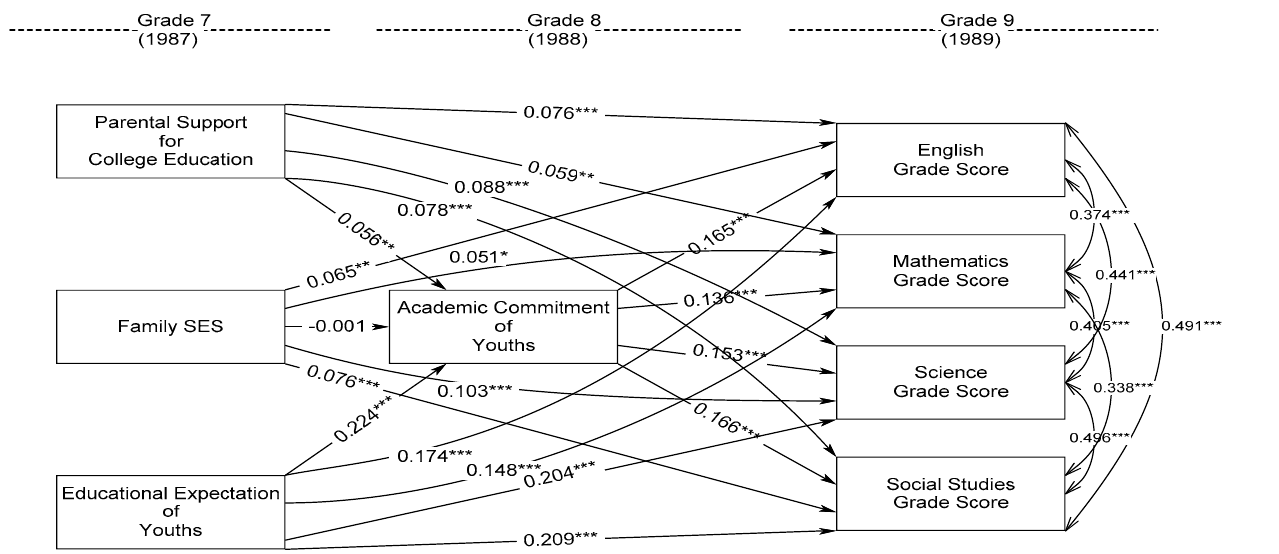
Figure 1. Standardized Effects of Parental Support for College Education, Family SES, and Educa- tional Expectation of Youths in Grade 7 on Youths’ Grade-9 Educational Performance through Youths’ Grade-8 Academic Commitment (Model 1). Note. The gender, family structure, and ethnic origins of youths were adjusted in modelling procedures but skipped in presentation for simplicity. Family SES= family Socioeconomic Status. Model fit: CFI = 1.00, RMSEA = 0.00, and SRMR = 0.00. * p <0.05; ** p < 0.01; *** p < 0.001.